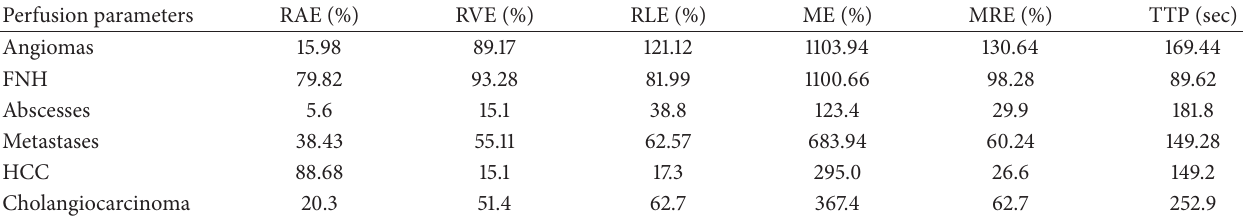
Table 2: Summarizing table of the overall perfusion data obtained in each liver entity analyzed.